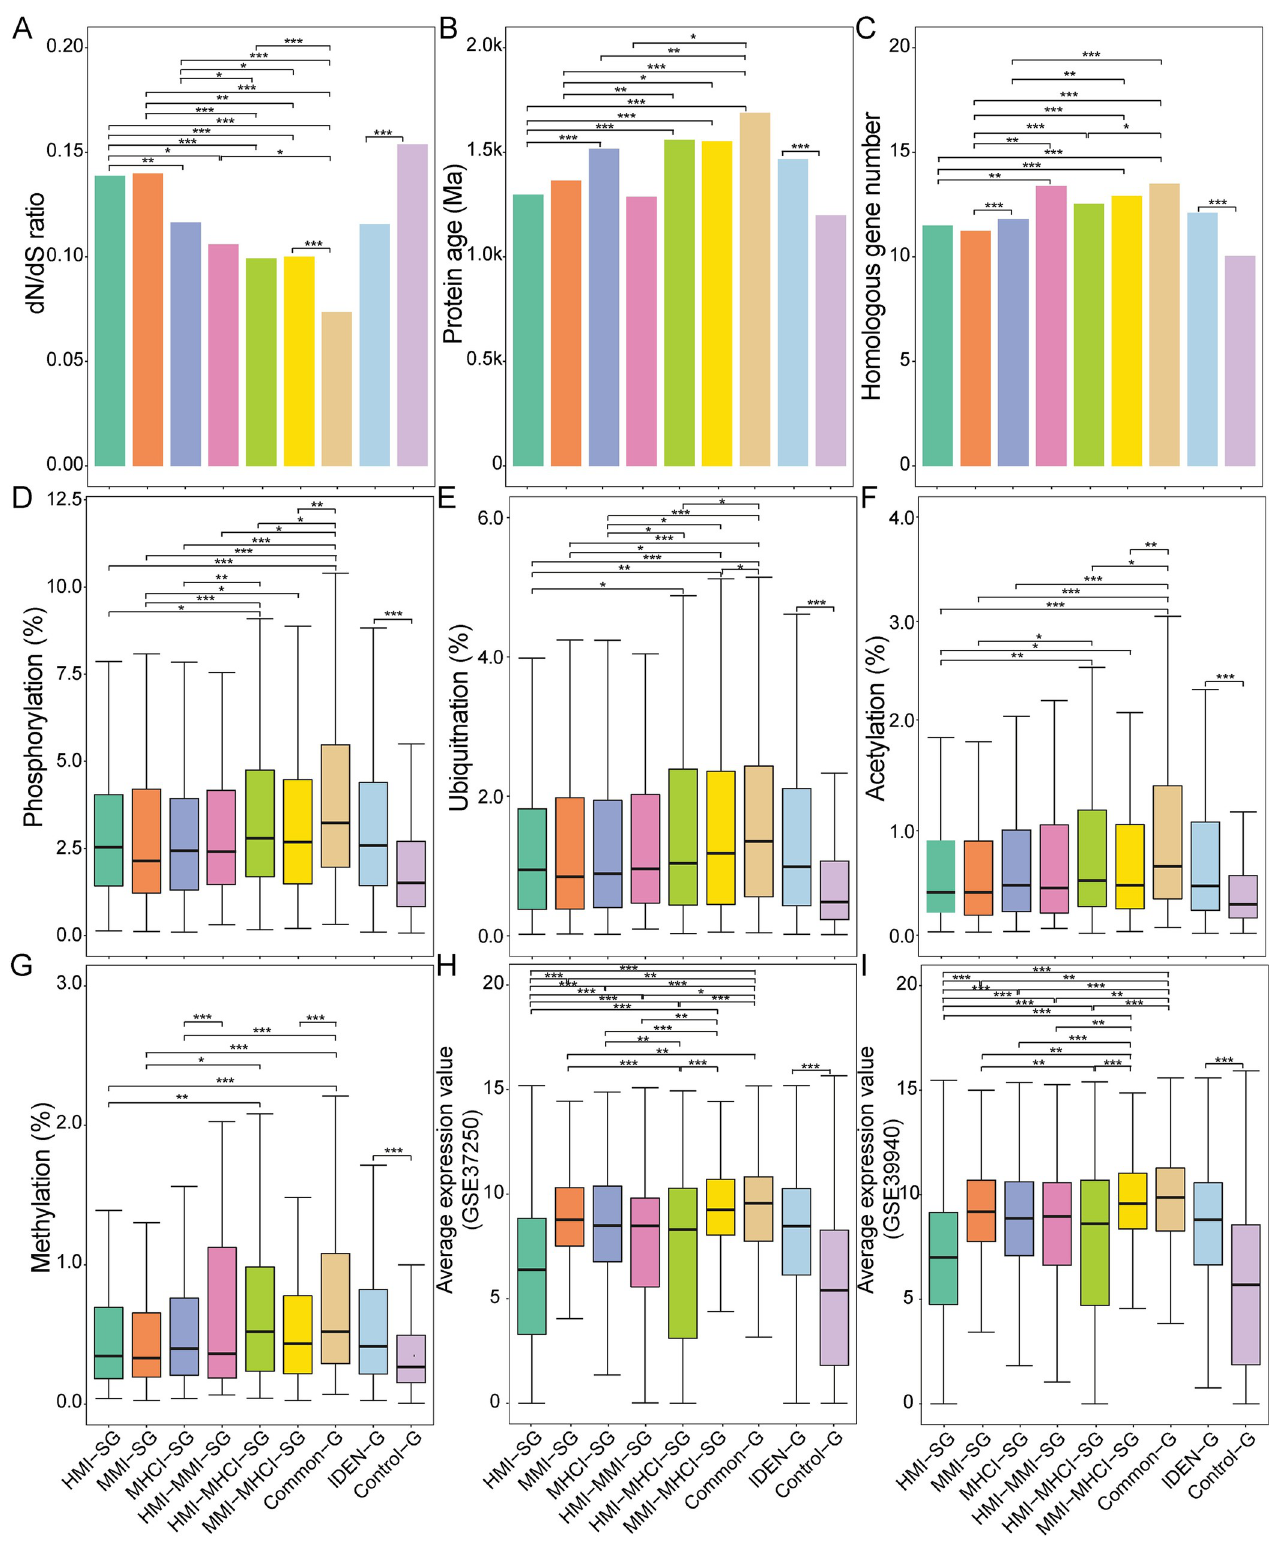
Fig 4. Evolutionary and expression features of disease-related genes. (A) dN/dS ratio. (B) Protein age. (C) Number of homologous genes. (D) Proportion of phosphorylated sites. (E) Proportion of ubiquitinated sites. (F) Proportion of acetylated sites. (G) Proportion of methylated sites. (H) Expression level of detected genes (GSE37250). (I) Expression level of detected genes (GSE39940). ��� P < 0.001, �� 0.001 � P < 0.01 and � 0.01 � P < 0.05.